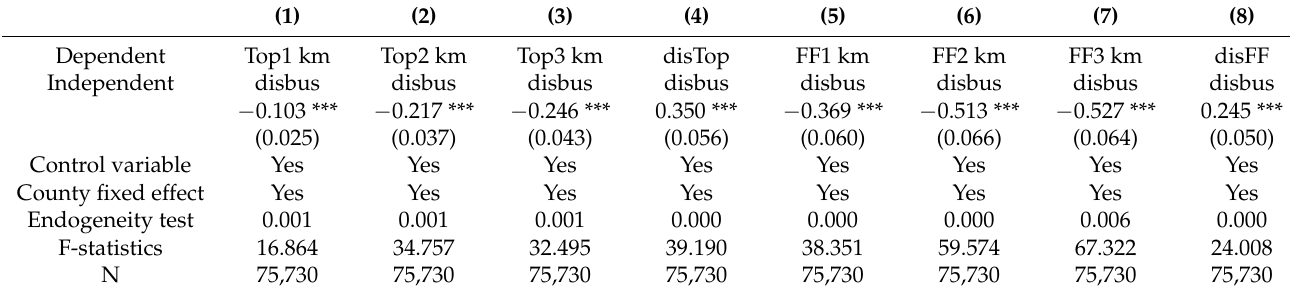
Table 4. Results of the first stage.